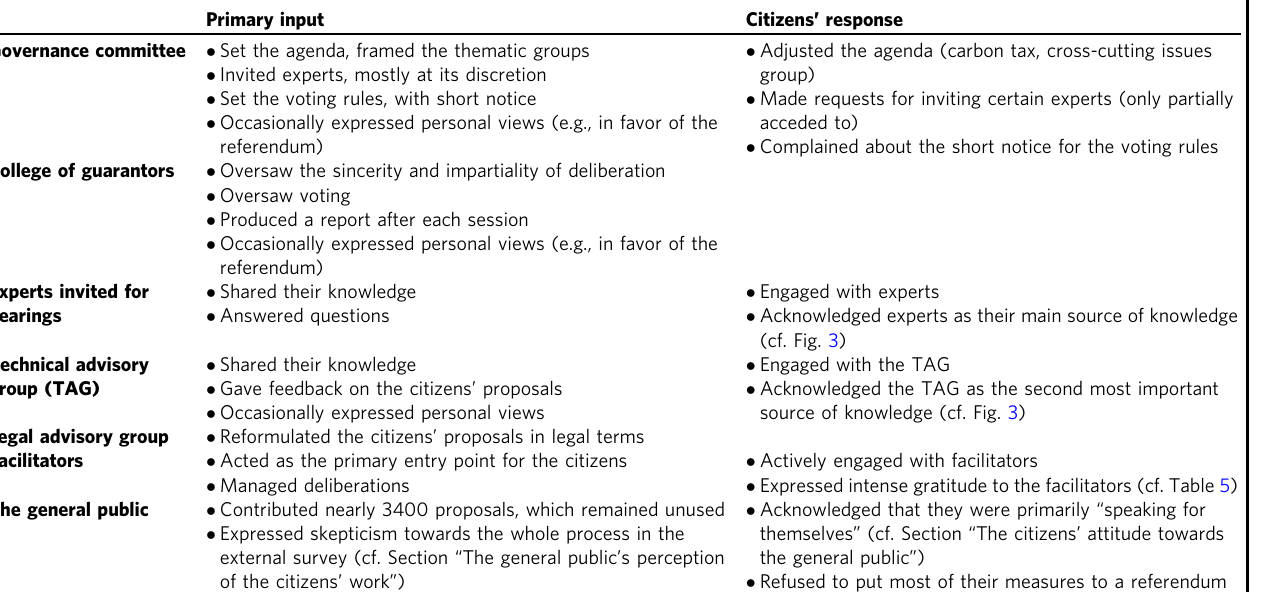
Table 6 Summary of interactions between the citizens and various